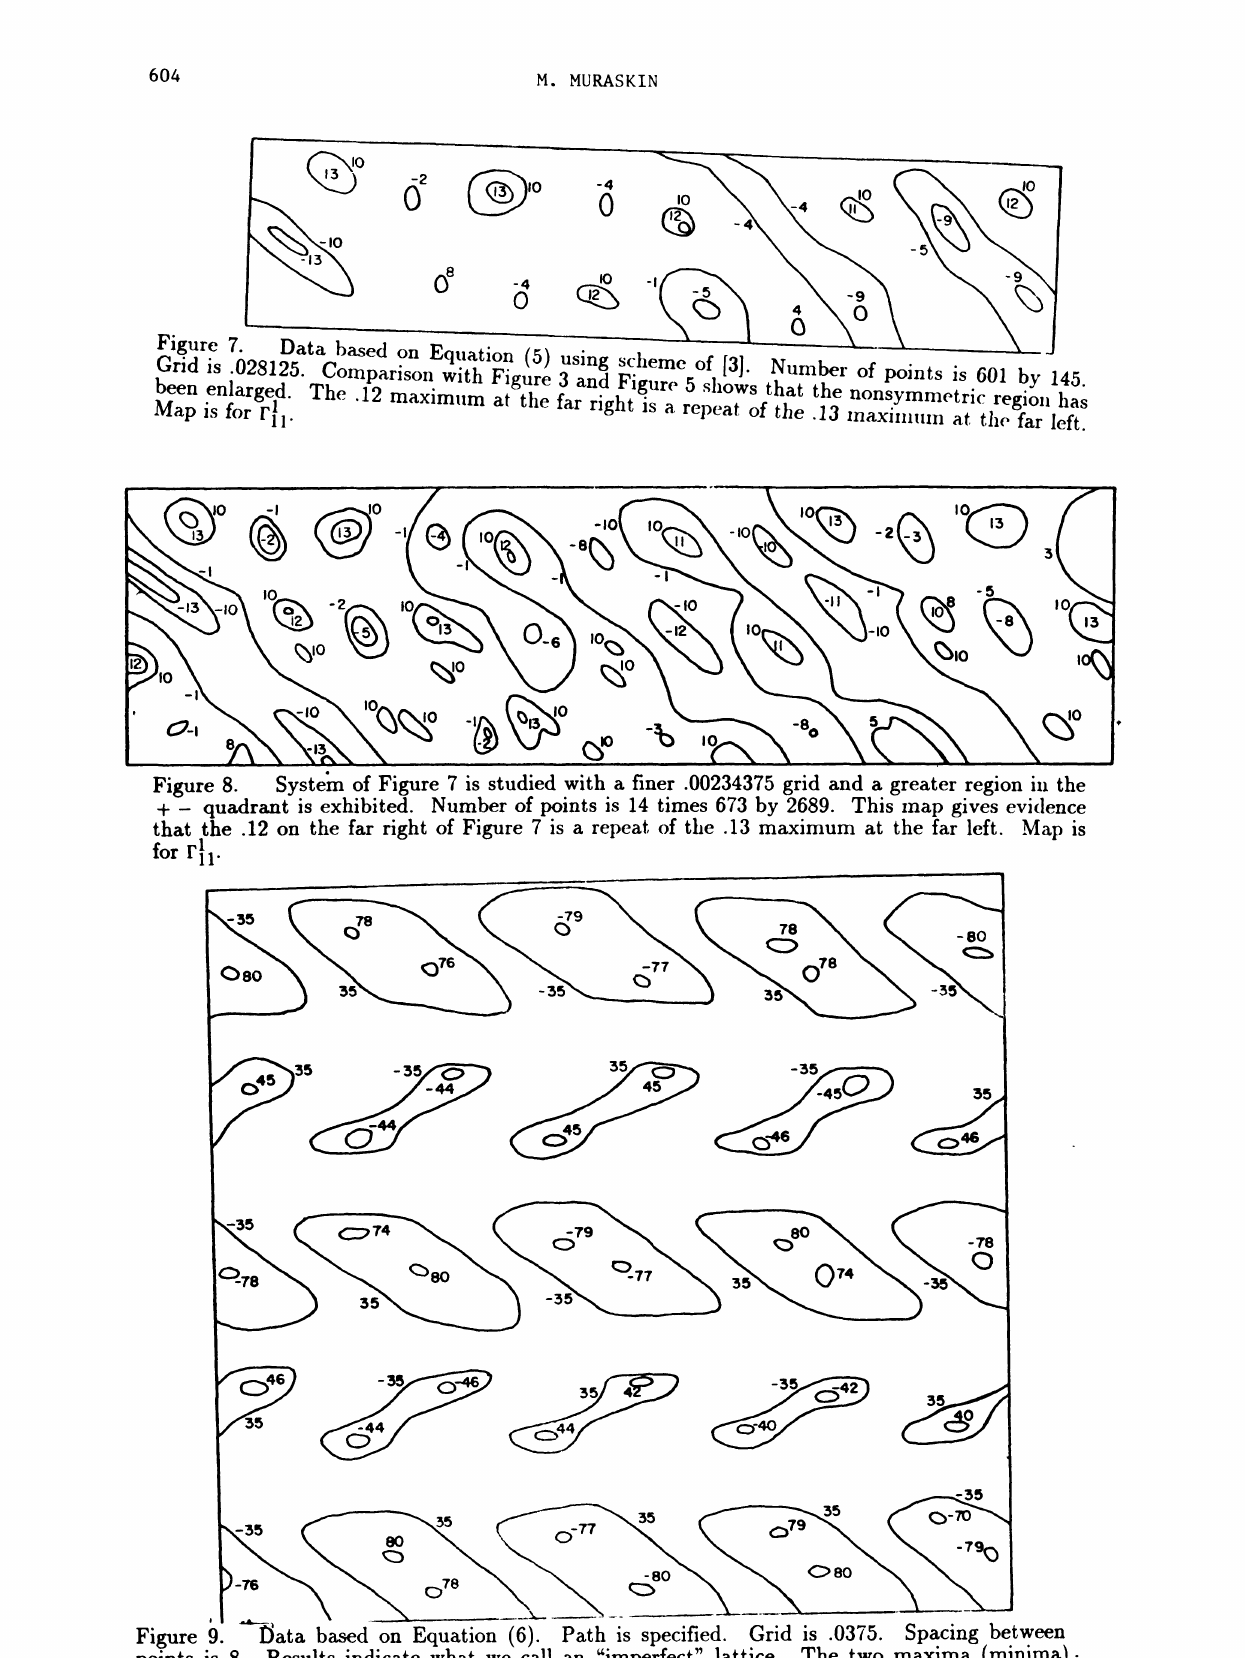
i. "--i:Jata based Figure on Equation (6). Path is specified. Grid is .0375 Spacing between points is 8. Results indicate what we call an "imperfect" lattice. The two maxima (minima). r]l is within a contour line have slightly different magnitudes in general,